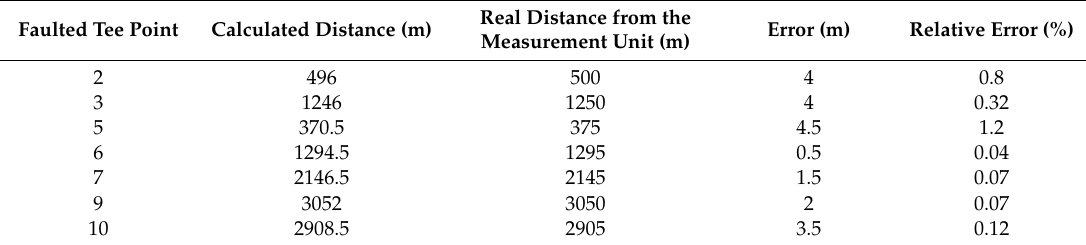
Table 2. Fault location at di ff erent tee points.